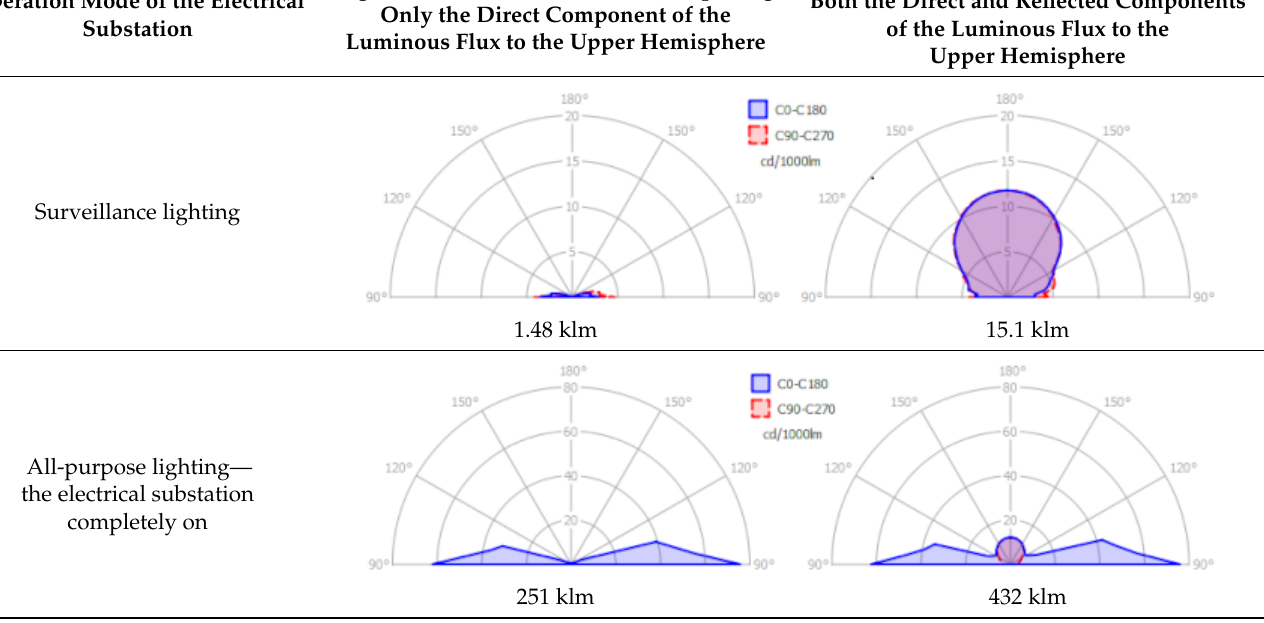
Table 5. Light emission characteristics of two operational modes of the electrical substation TR Prosenice before